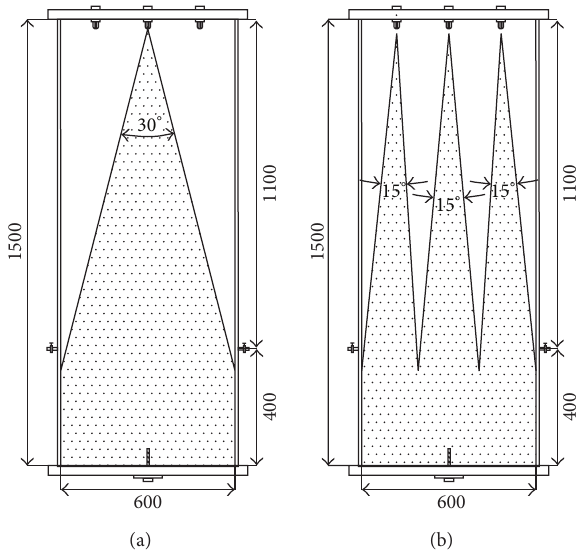
Figure 6: The influences of multinozzle configuration on the dilution capacity of water sprays at various water flow